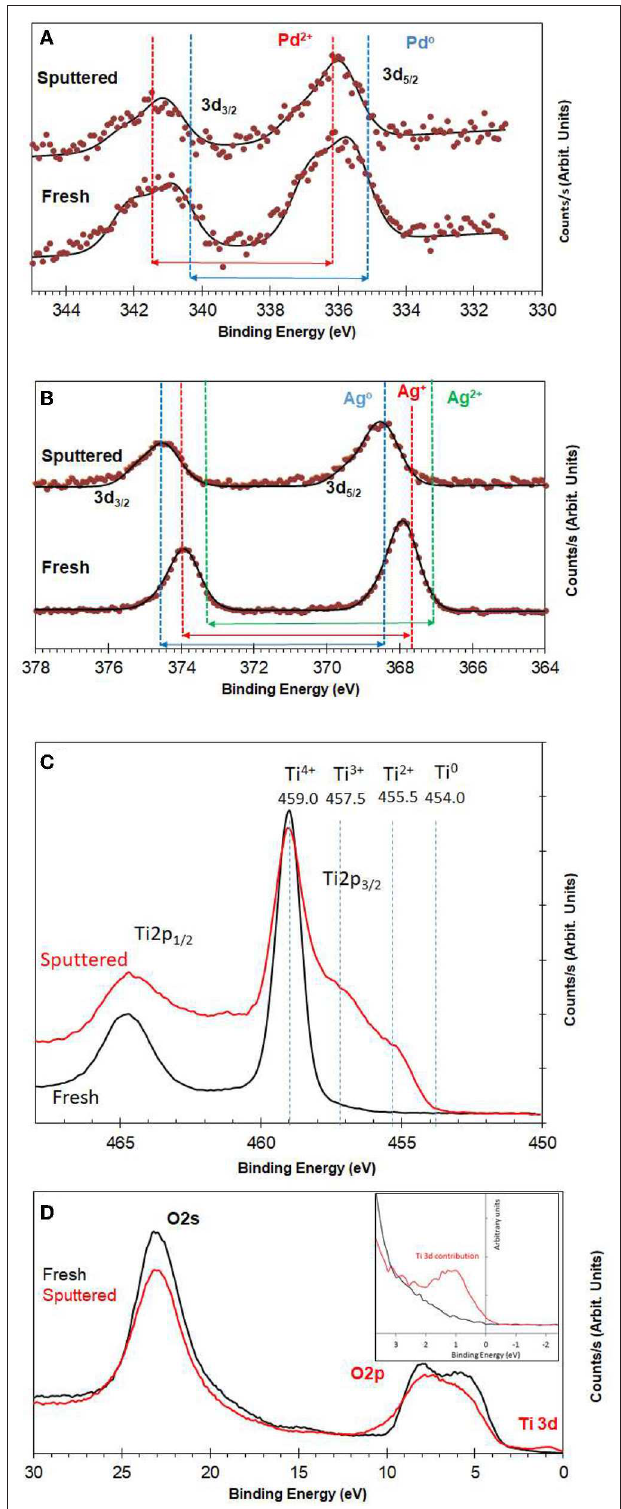
FIGURE 3 | (A) XPS Pd3d for fresh and Ar + -bombarded 0.1 wt.% Ag − 0.3 wt.% Pd/TiO 2 (anatase) catalyst; (B) XPS Ag3d for fresh and Ar + -bombarded